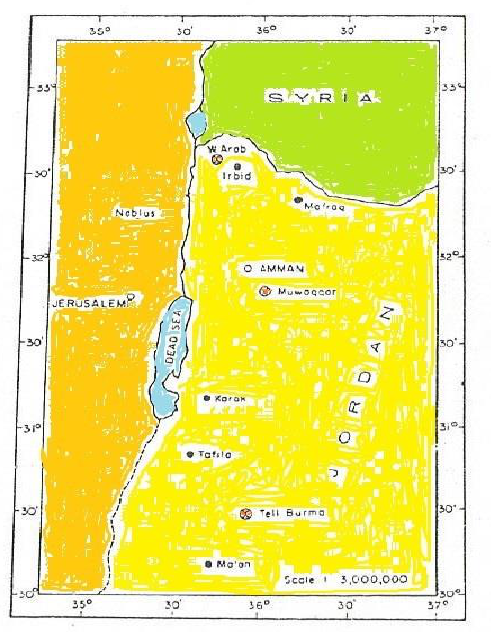
Figure 1: Location map of the seven Egyptian sedimentary facies, including some sections: Maqfi, Wadi Mellaha sections (Farafra Facies, Figure 2: Location map of the three diagnostic sections in Jordan: Wadi central Egypt), Duwi, Gurnah, Dandara, Owaina sections, and Ain Arab section (North Jordan), Muwaqqar section (Central Jordan) and Tell Dabadib, Ghanayem sections (Nile Valley Facies, southern Egypt) (Issawi, Burma section (South Jordan) (Futyan, 1972).